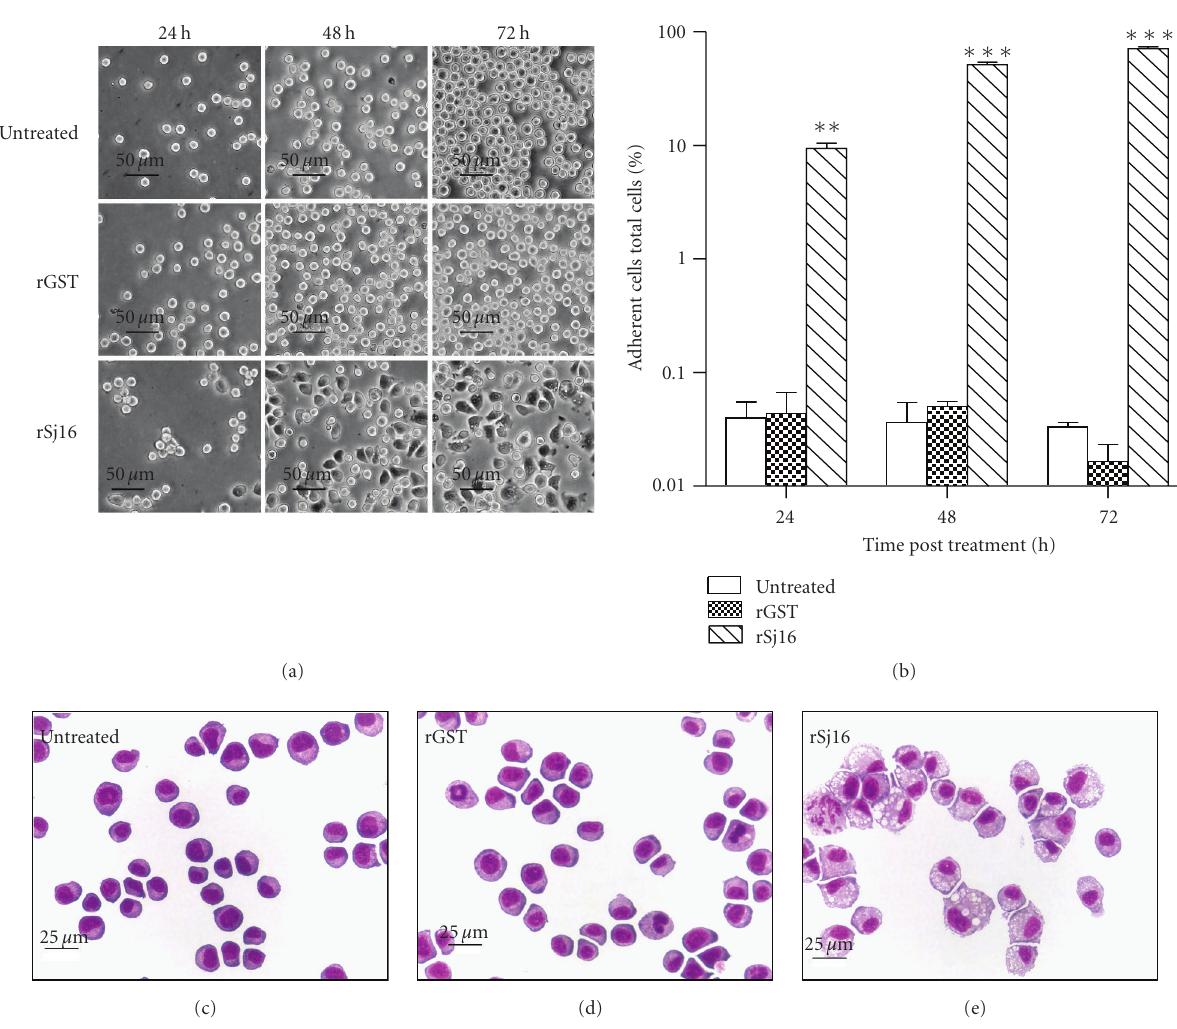
Figure 3: E ff ect of rSj16 on adherence and morphology of WEHI-3B JCS cells. WEHI-3B JCS cells were treated with 0.5 μ g/ml rSj16 ( rSj16 ), 0.5 μ g/ml rGST ( rGST ), or medium alone ( untreated ) for various time periods, and morphological changes were studies using a light microscope (Nikon). (a) Time course morphological changes of WEHI-3B JCS cells (magnification, × 200). Black bars represent 50 μ m. (b) Induction of adherence of WEHI-3B JCS cells after exposure to rSj16. The data were expressed as mean ± SEM, n = 3. ∗∗ P < . 01; ∗∗∗ P < . 001 as compared with that of untreated group. (c)–(e) Modified Wright Giemsa staining of WEHI-3B JCS cells 72 hours post treatment (magnification, × 400). Black bars represent 25 μ m. Data are representative of three individual